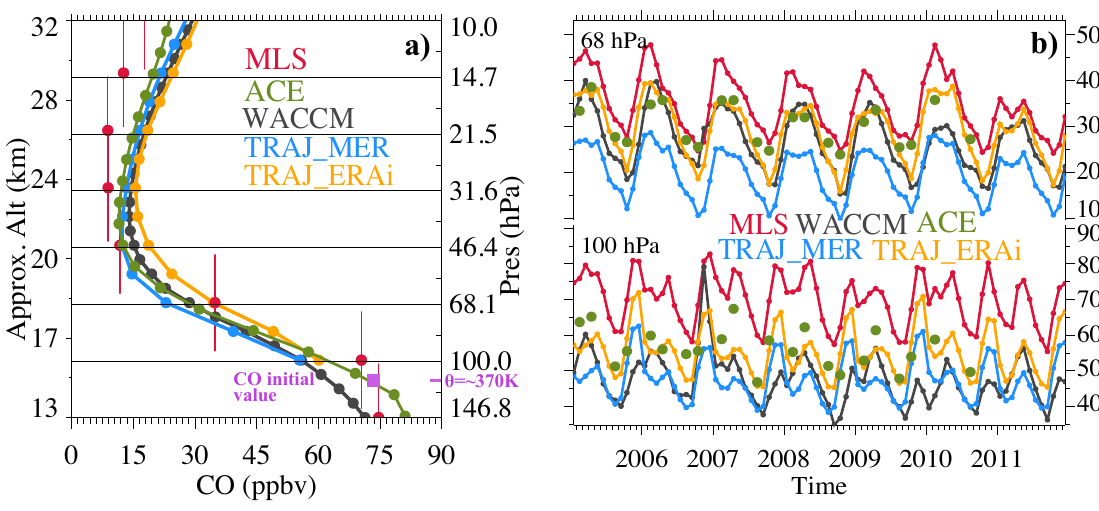
Figure 9. Tropical (a) vertical profile and (b) time series (100hPa, bottom panel; 68 hPa, upper panel) of MLS, WACCM, ACE, and trajectory Figure 10. model results using AK Model results mainly modeled CO driven by MERRA wind and ERAi wind, averaged over 15 ◦ N–15 ◦ S from 2005 to 2011. In (b) the WACCM and trajectory Model results mainly model results are weighted by the MLS averaging kernels. In (a) the purple square indicates the initial CO values carried by parcels when compare to ACE, so didn’t compare to MLS, so used AK they were first injected into the domain at 370K, and vertical bars in red indicate the MLS vertical resolutions at each of the MLS retrieval use AK pressure levels.